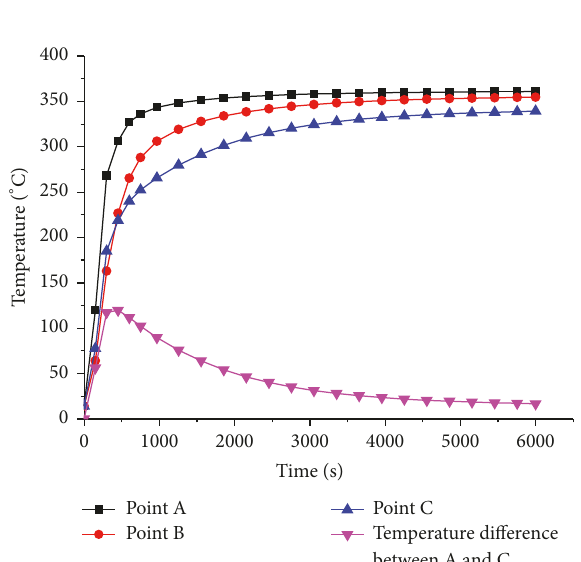
Figure 8: Temperature distribution of the rotor at time of 6000 s/ ∘ C.